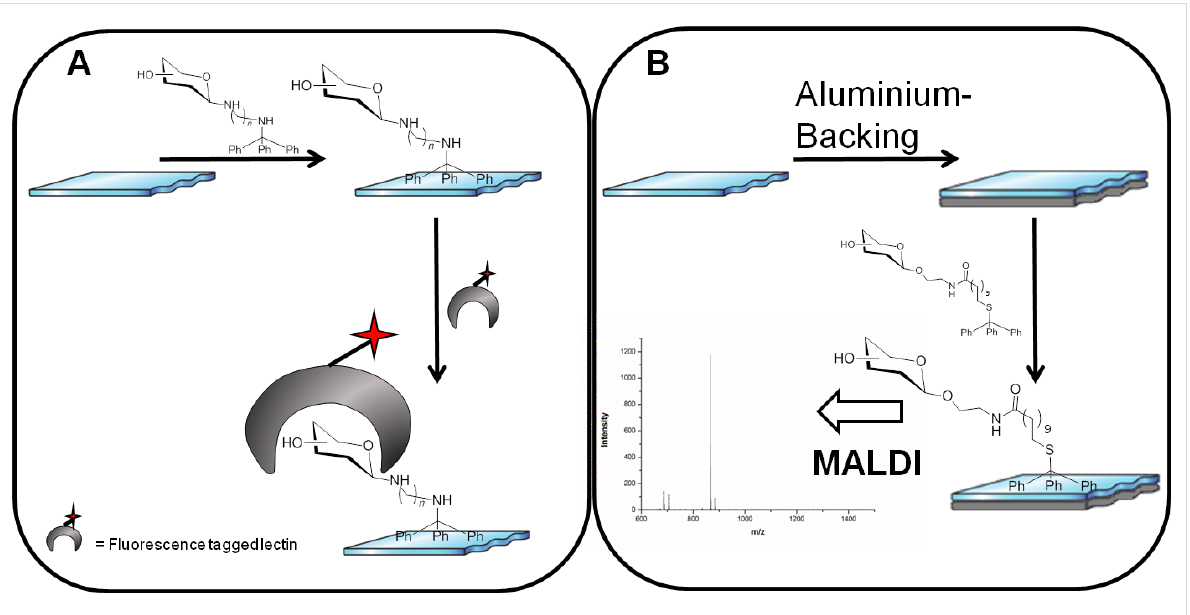
Figure 1: Carbohydrate arrays on polystyrene slides can be obtained by noncovalent immobilisation of tritylated saccharide derivatives. (A) Lectin- mediated analysis of carbohydrate arrays [7]. (B) The new concept of label-free MALDI-TOF MS analysis by aluminium-backing of polystyrene or glass